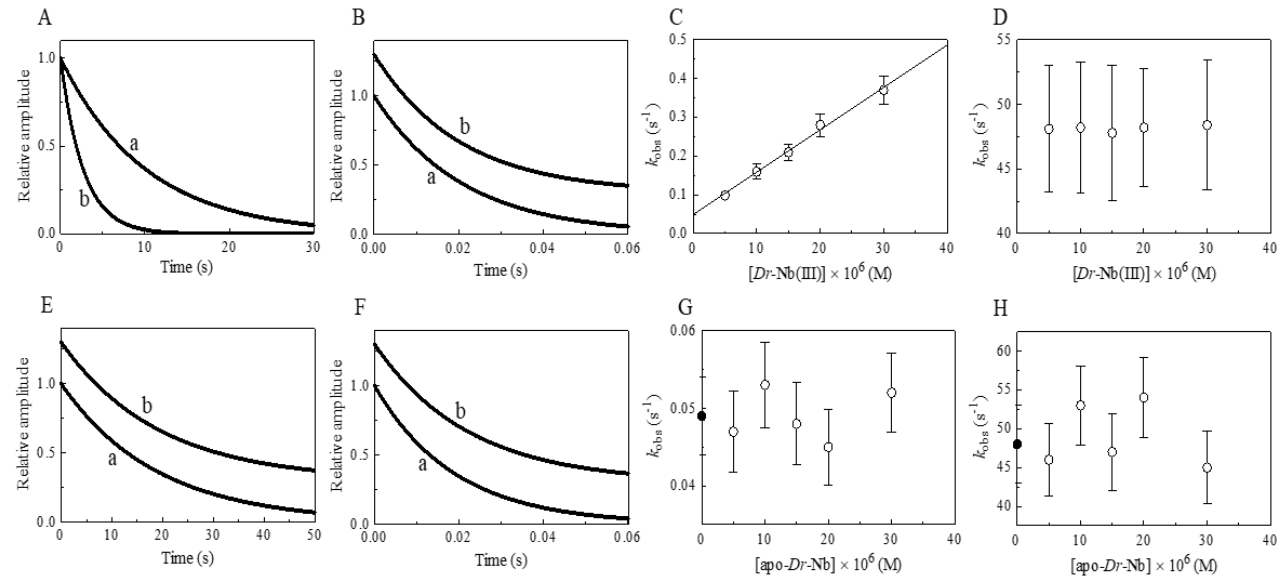
Figure 3. Effect of Dr -Nb(III) on the kinetics for peroxynitrite isomerization, at pH 8.5 and 22.0 °C. ( A ) Averaged time courses of the Dr -Nb(III)-catalyzed isomerization of peroxynitrite in the absence of CO 2 . The time course analysis according to Equation (1) allowed us to determine the following values of k obs : trace a, 1.0 × 10 − 1 s − 1 , R = 0.998; trace b, 3.7 × 10 − 1 s − 1 , R = 0.999. The Dr -Nb(III) concentration was: trace a, 1.0 × 10 − 5 M; trace b, 3.0 × 10 − 5 M. ( B ) Averaged time courses of the Dr - Nb(III)-catalyzed isomerization of peroxynitrite in the presence of CO 2 . The time course analysis